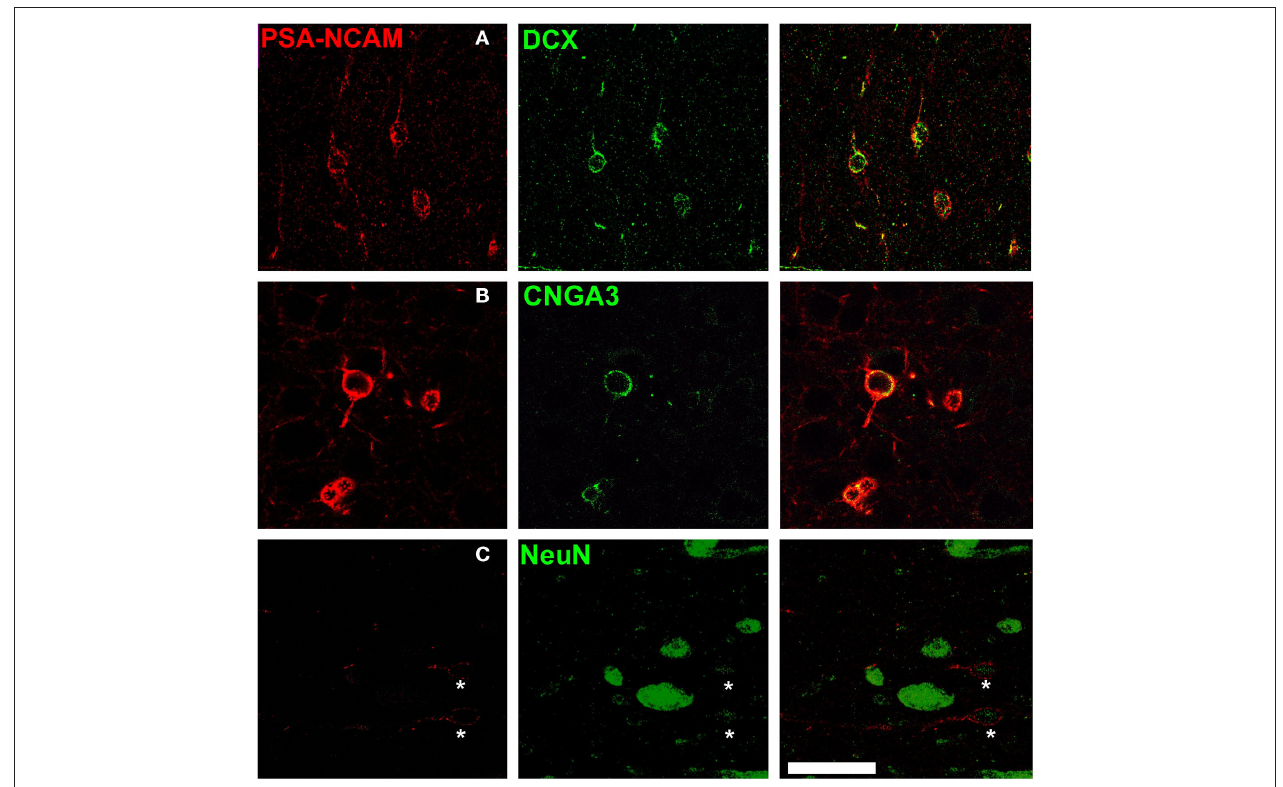
expressing cells in layer II (asterisks) express weakly NeuN, a nuclear marker expressed by mature neurons (C) . All the images in this figure are 2D projections of three consecutive confocal planes located 1 μm apart. Scale bar: 25 μm.